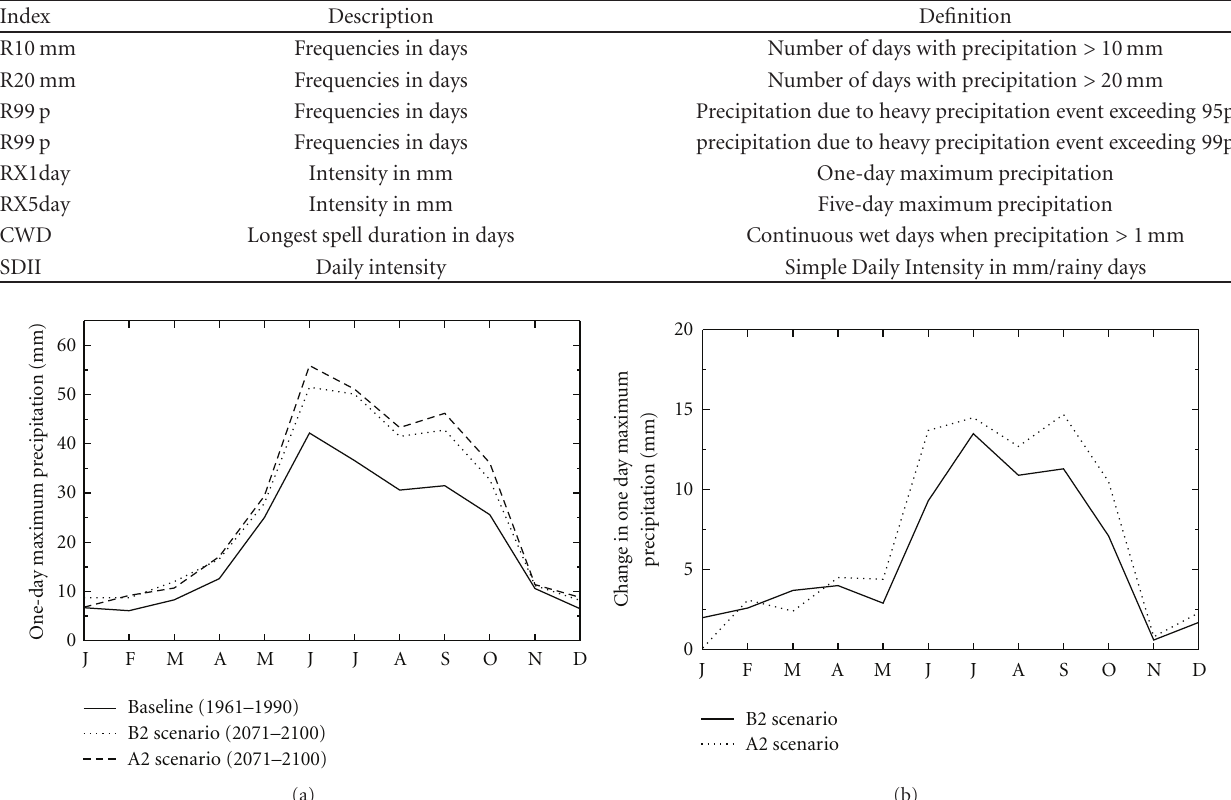
Table 1: List of Indices used in the study.